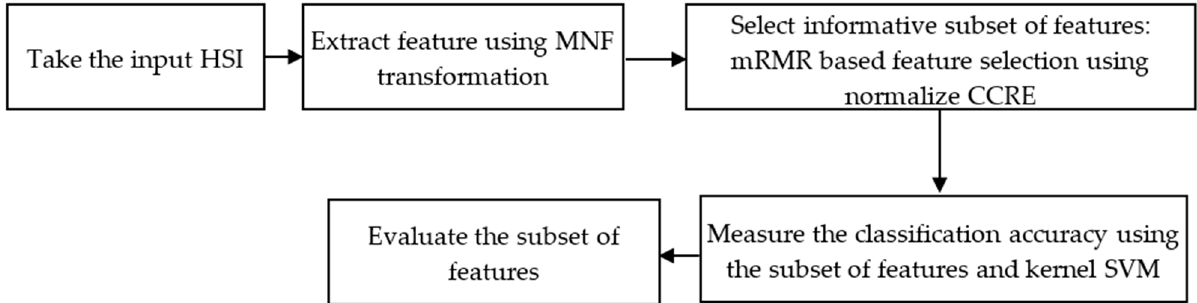
Figure 1. Overview of the proposed